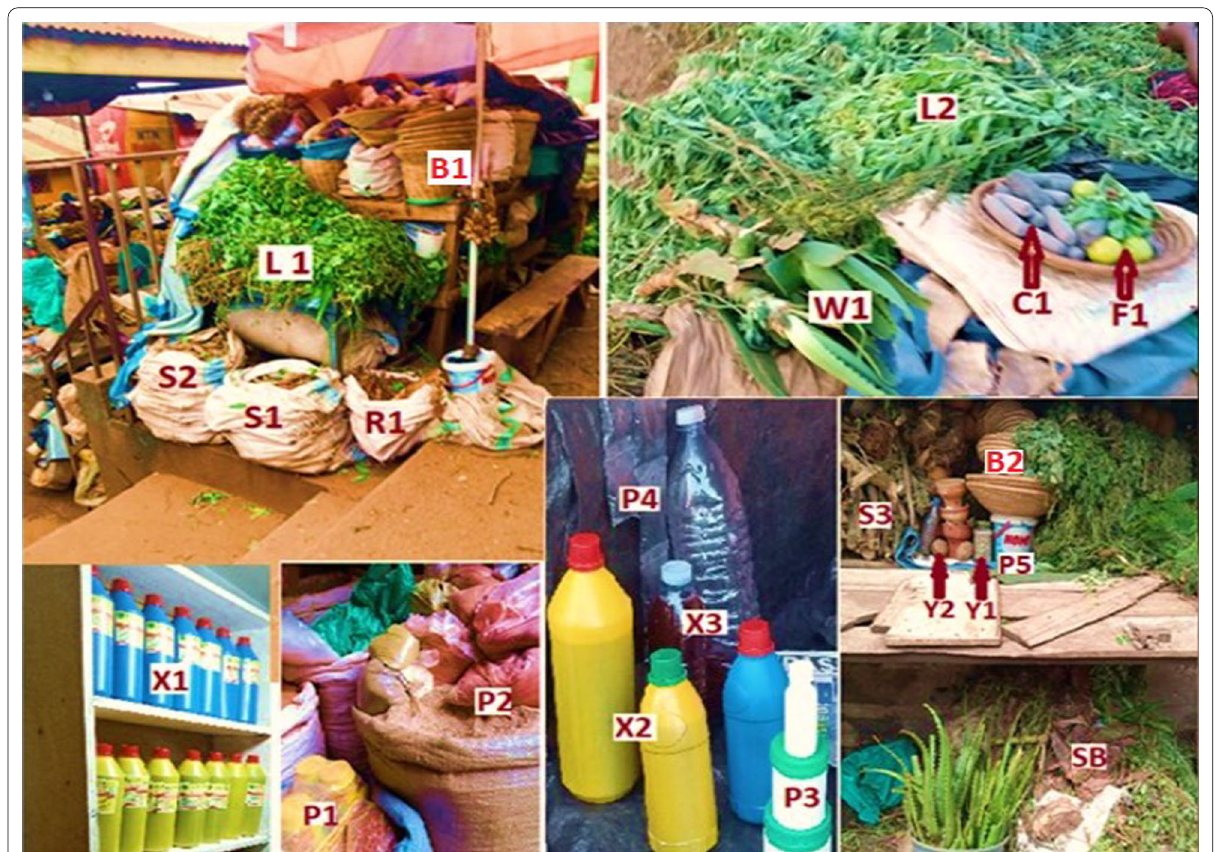
Fig. 6 a Pharmaceutical forms of commercial HM in Kampala: (i) Herbal Medicine Products [Liquid preparations (X1, X2, X2), Powders (P1, P2, P4, P5), Gels (P3), Herbal extracts concocted in clay (C1)]. (ii) Herbal substances [Leaves (L1), Stems (S1, S2, S3), Roots (R1), Whole plant (W1, L2), Fruits (F1), Seeds (Y1, Y2), Stem barks (SB)]. b Categories of HM packaging material: (i) Original packages [Plastic bottles (X1, X2), Polyethene bags (P2, P4), Tins (P3)], (ii) Recycled packages [Sacks (S1, S2, R1), Bottles (X3), Buckets (P5), Baskets (B1,